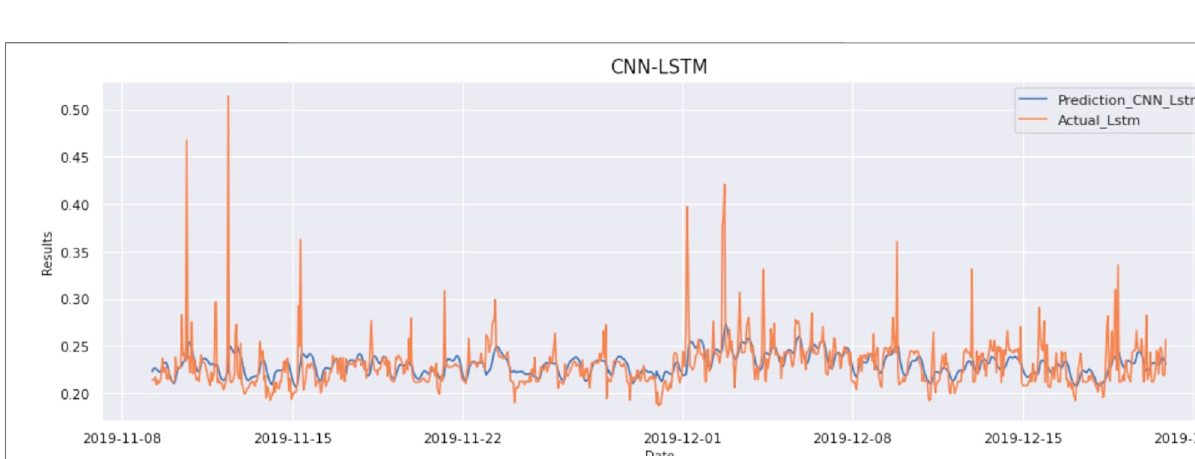
FIGURE 7 | Prediction vs Actual result of LSTM model (Ontario Demand Data).